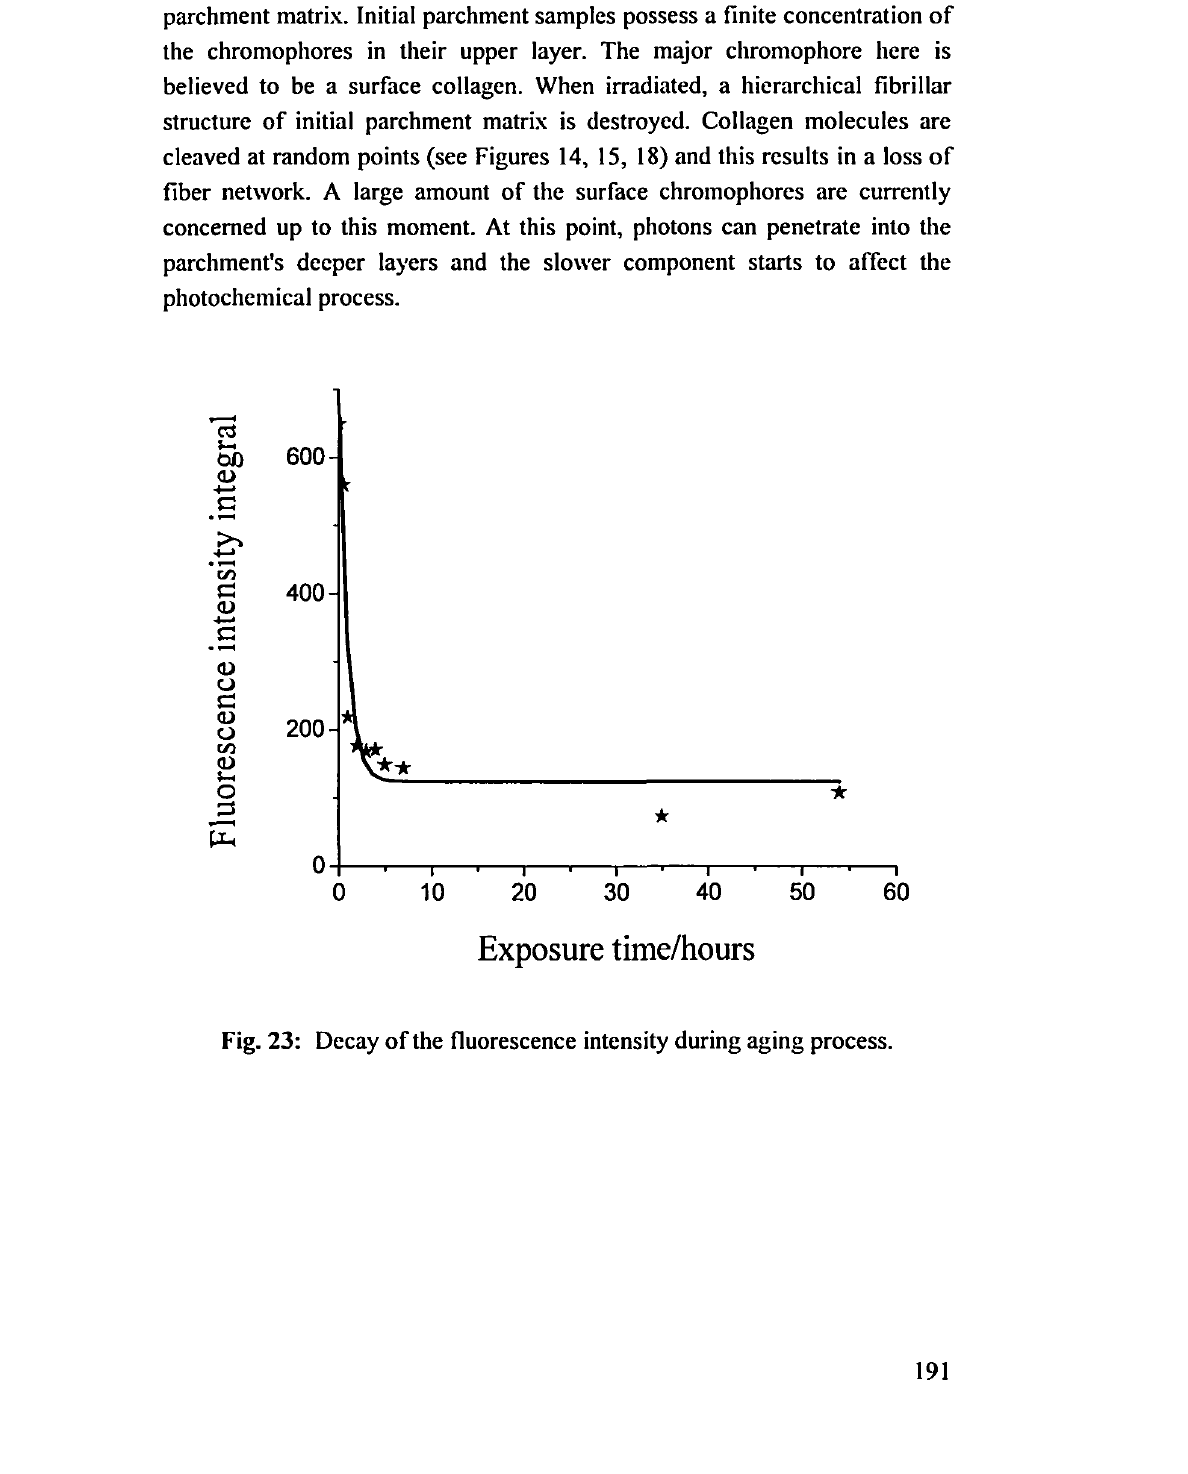
Fig. 23: Decay of the fluorescence intensity during aging process.